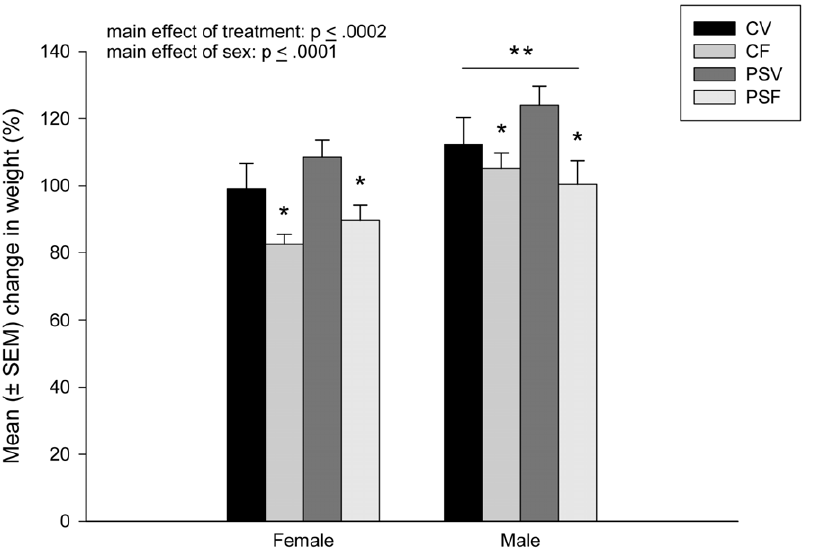
Figure 3. Mean ( ± SEM) percentage in weight change from P29 to P42. CF and PSF offspring gained significantly less weight than CV and PSV offspring, regardless of stress (p # .0002). Overall, male adolescent offspring gained significantly more weight than female offspring (p # .0001). ‘*’denotes CF and PSF significantly different from CV and PSV groups. ‘**’ denotes males significantly different from females. (n=9–11/sex/group).